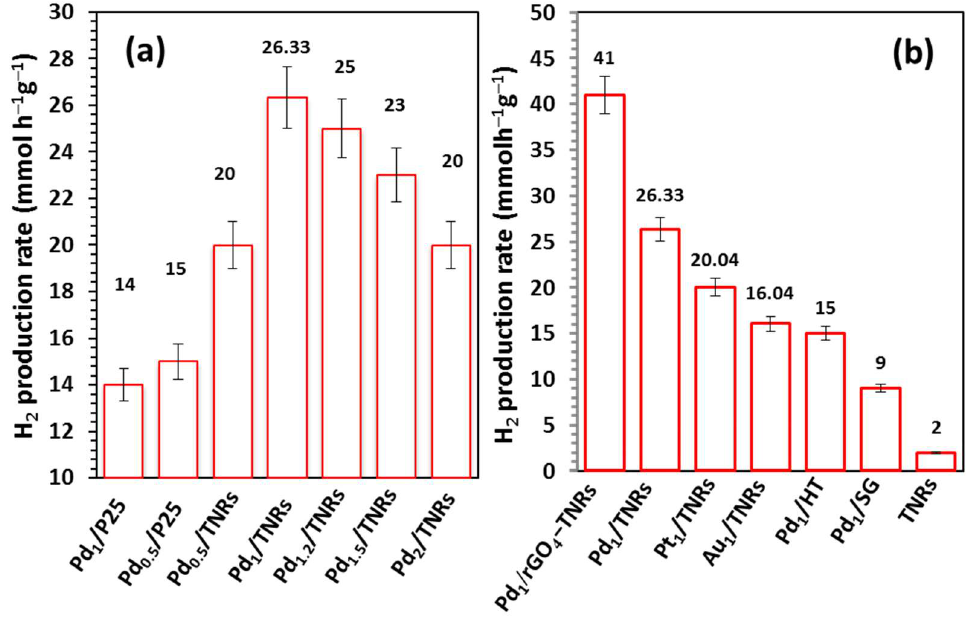
Figure 7. ( a ) Metal co-catalyst loading optimization on TNR and benchmark P25 and its effect on amount of H 2 production in 5 vol.% glycerol–water mixtures. ( b ) Comparison of Pd 1 /rGO 4 −TNRs with other benchmark photocatalysts prepared with different supports.